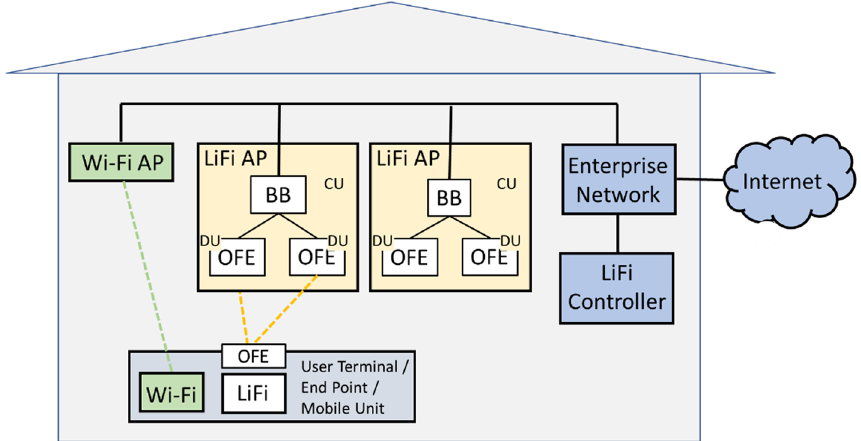
Fig. 2 Indoor system architecture overview comprising LiFi and Wi-Fi: each LiFi access point (AP) has a LiFi central unit (CU) that performs the baseband (BB) PHY and MAC layers and connects to multiple distributed units (DUs) which are optical front ends (OFEs) in the ceiling. The user terminal is also referred to as mobile unit